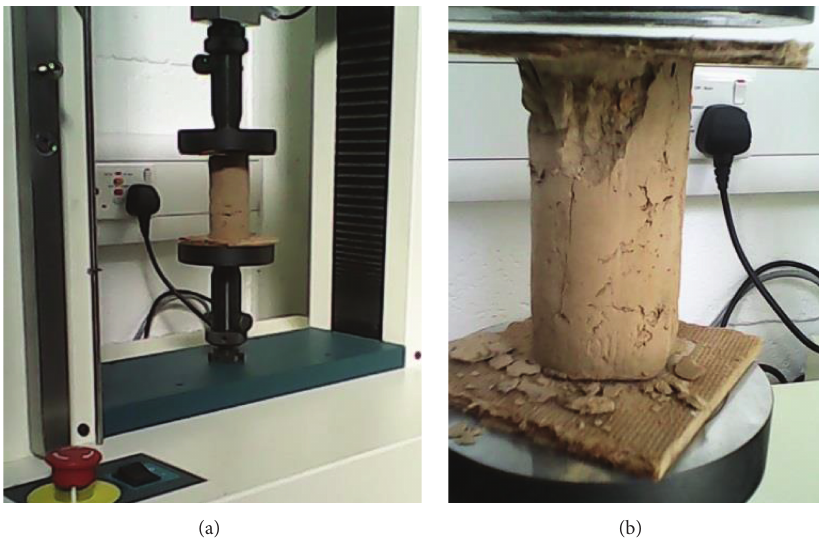
Figure 4: (a) Specimen under compressive stress, (b) failed specimen.